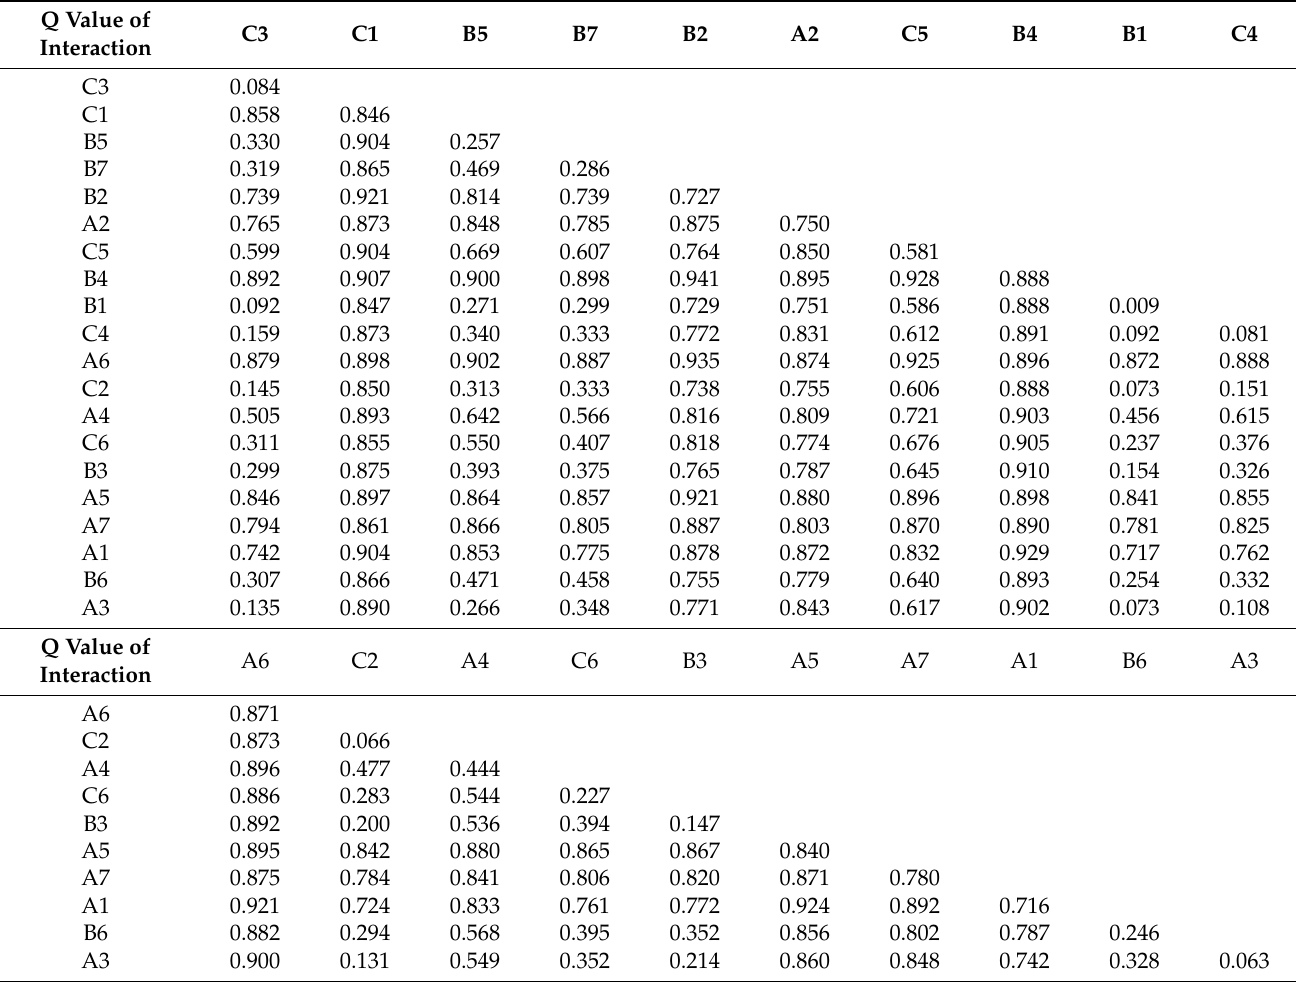
Table 11. Interactions among driving factors to socio-ecological vulnerability in Aba